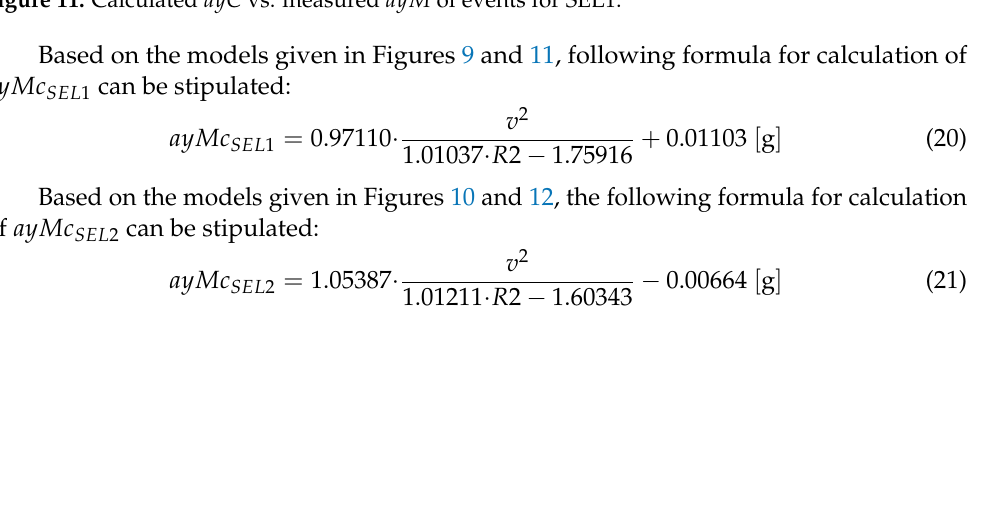
Figure 12. Calculated 𝑎𝑦𝐶 vs. measured 𝑎𝑦𝑀 of events for SEL2. Based on the models given in Figures 10 and 12, the following formula for calculation of 𝑎𝑦𝑀𝑐 (cid:3020)(cid:3006)(cid:3013)(cid:2870) can be stipulated: 𝑎𝑦𝑀𝑐 (cid:3020)(cid:3006)(cid:3013)(cid:2870) = 1.05387 ∙